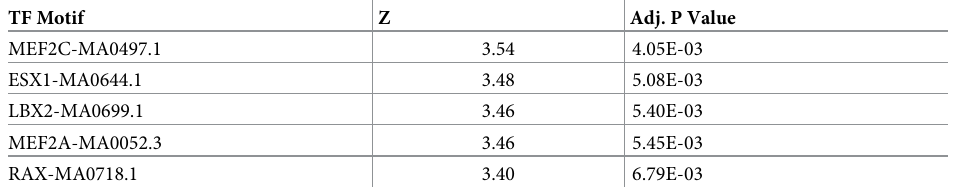
Table 1. Top 5 strongest positive associations between TF motif networks and schizophrenia risk in brain